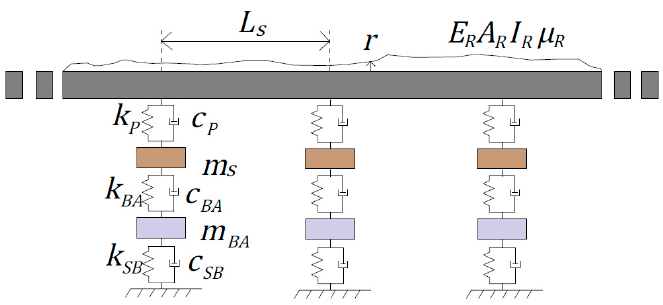
Figure 2. Track Figure 2. Track model.